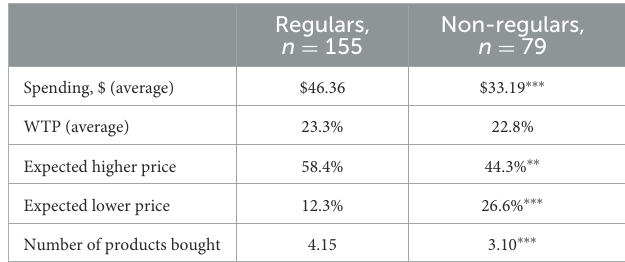
TABLE 5 Regulars vs. non-regulars on spending, WTP, and price